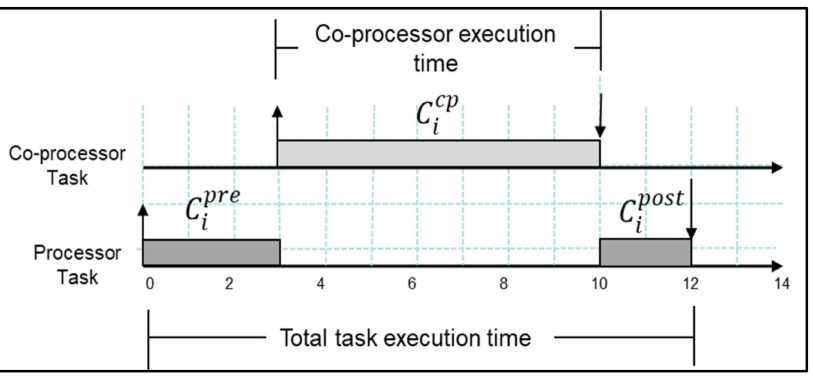
Figure 1. CPU-GPU task